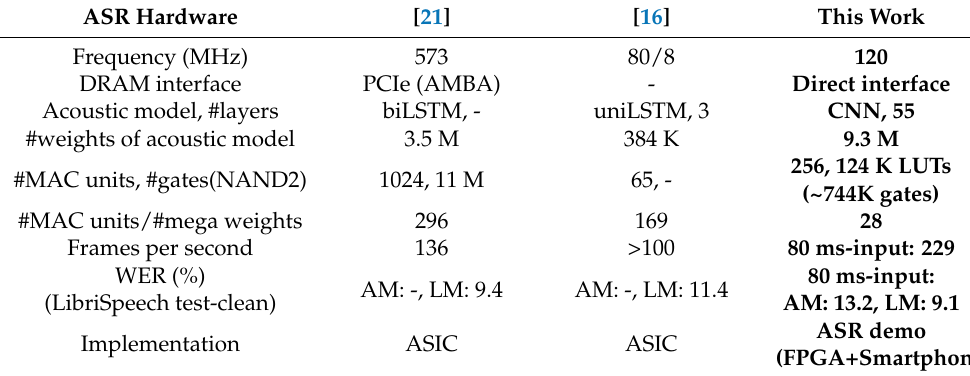
Table 15. Comparison of ASR inference hardware for LibriSpeech